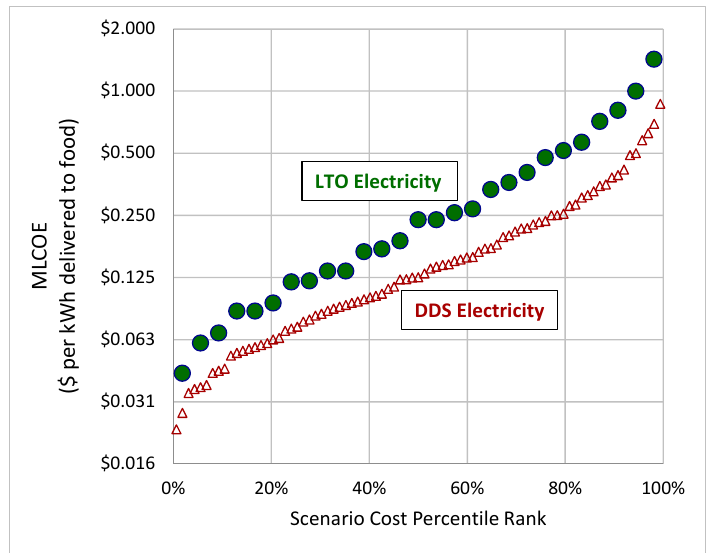
Figure 9. MLCOE distribution for LTO-battery-regulated electricity in a DDS SEC compared with the MLCOE distribution for unregulated DDS electricity. The LTO MLCOE is the distribution illustrated with the green circles. The DDS electricity cost is illustrated with the triangles. DDS electricity tends to be about 45% less expensive than LTO-regulated electricity. Note that the vertical axis has logarithmic scaling.